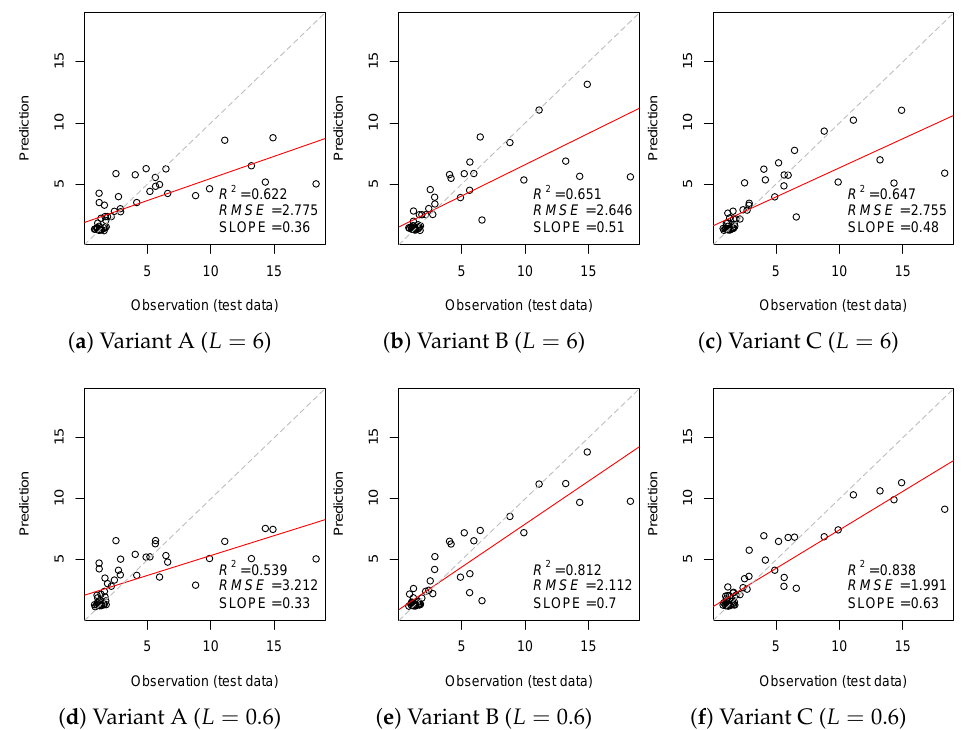
Figure 8. Comparison of SOC content (%) validation results based on test data sets for six prediction variants (cf., Table3). The red line is the regression line of the scatter plot, the gray and dashed line indicates the optimal regression line.